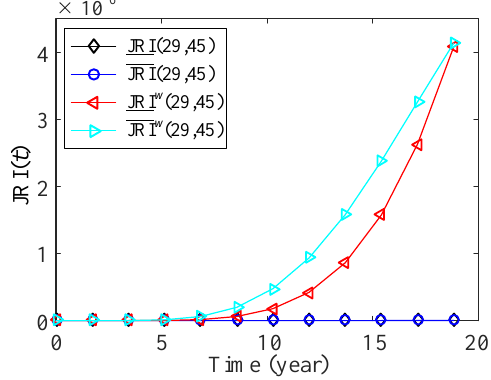
Figure 20. Lower and upper JRI of components 29 and 45.